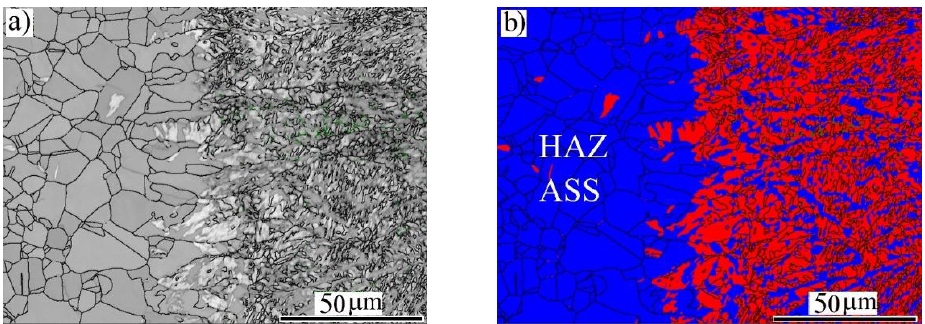
Figure 4. EBSD imaging maps of the fusion zone (FZ) near the fusion boundary (FB) of the BM-ASS at EI 50 J/mm: ( a ) image quality (IQ) map; ( b ) phase map α (cid:48) - bct in red and γ - fcc austenite in